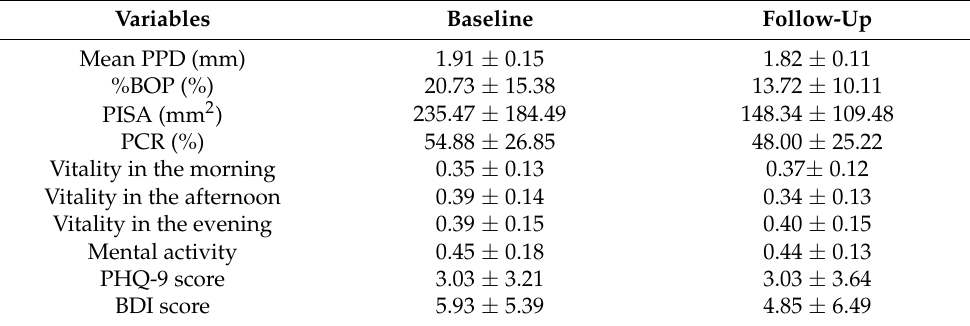
Table 1. Characteristics of